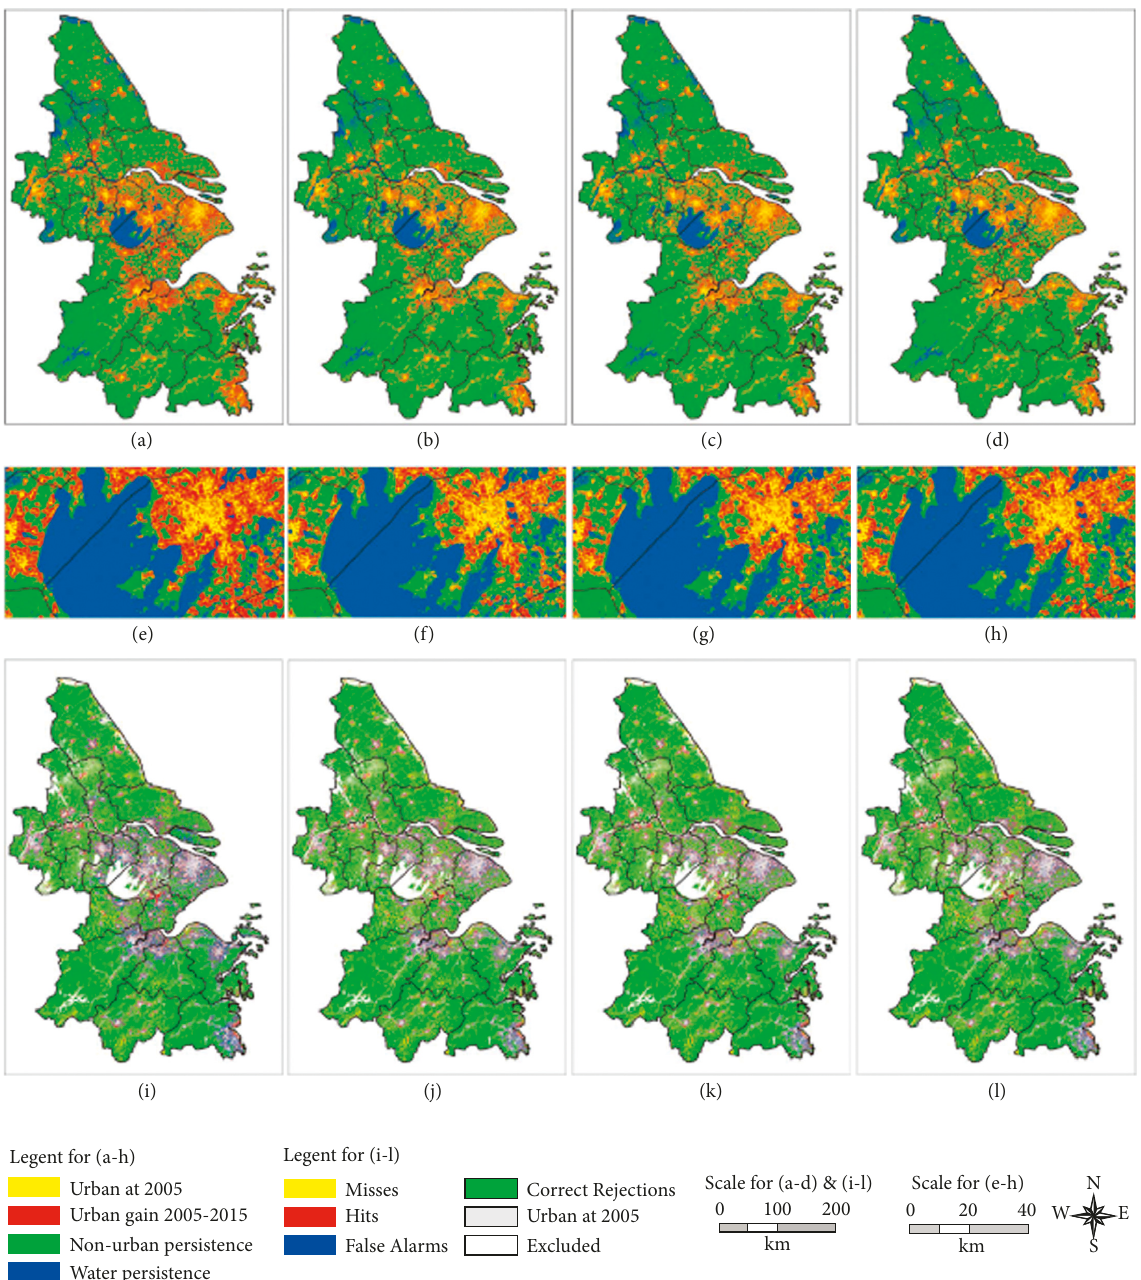
Figure 7: Modeled and actual urban growth in Ajmer (India) [44]. (a) Stimulated change by LR-CA. (b) Stimulated change by PSO-CA. (c) Stimulated change by GSA-CA. (d) Stimulated change by GA-CA. (e) Enlarged area of LR-CA. (f) Enlarged area of PSO-CA. (g) Enlarged area of GSA-CA. (h) Enlarged area of GA-CA. (i) Stimulation success and error by LR-CA. (j) Stimulation success and error by PSO-CA. (k) Stimulation success and error by GSA-CA. (l) Stimulation success and error by